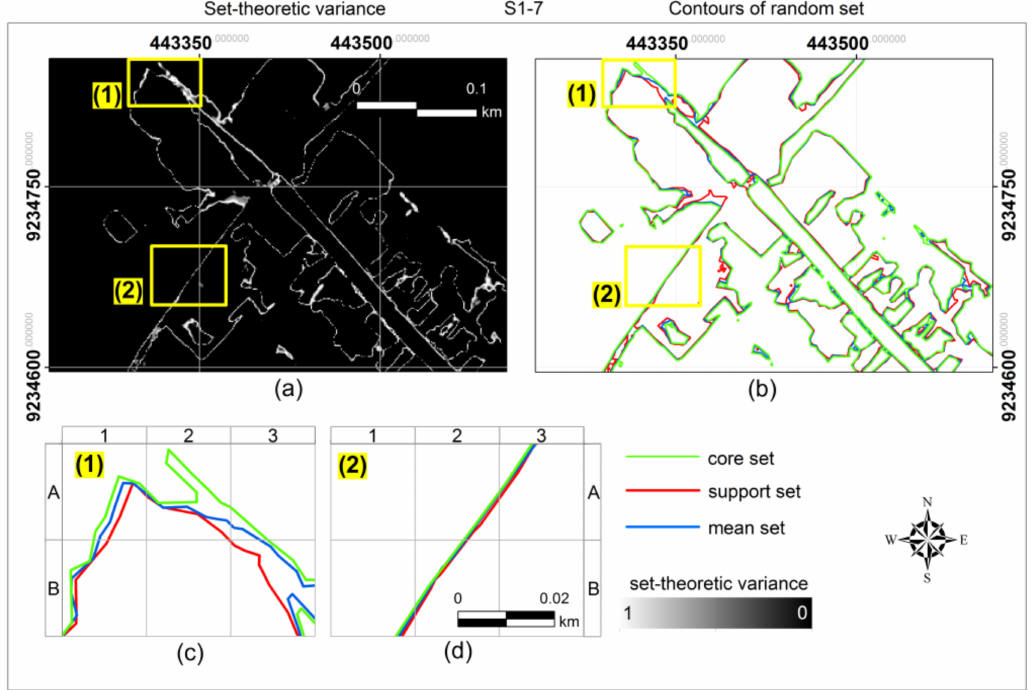
Figure 11. The set-theoretic variance ( a ); some examples of the contour of Γ 1 , Γ 0.5 and Γ 0 ( b ); and a detail representing the yellow rectangle sites as an example of contours with a broad variation ( c ); and contours with a small variation indicating a narrow shoreline ( d